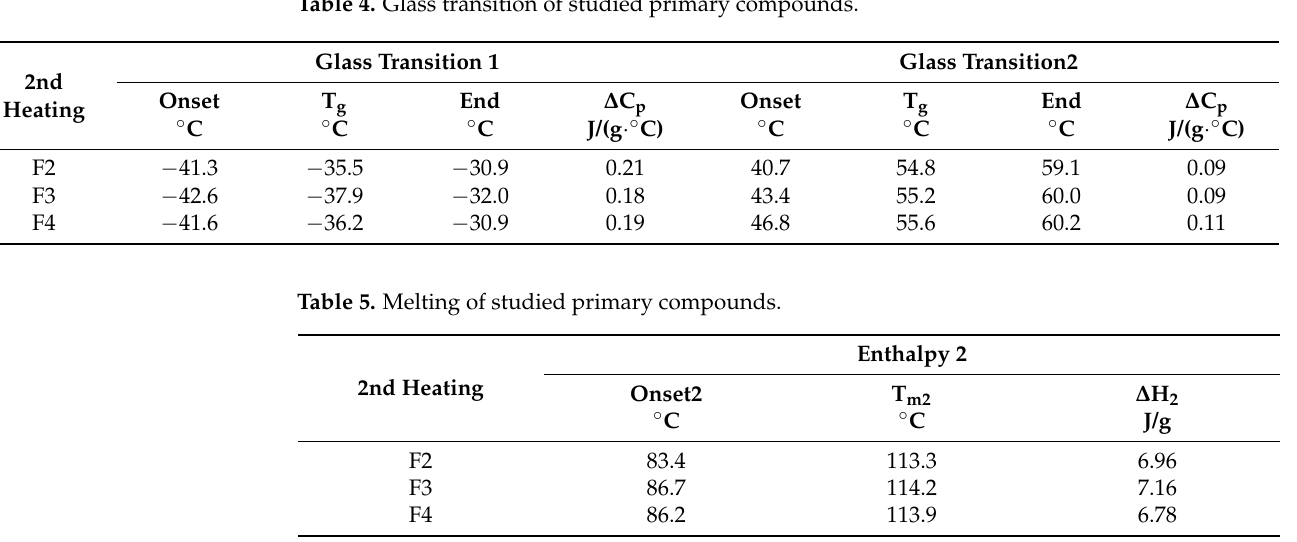
Table 6. Melting of mechanically recycled compounds.